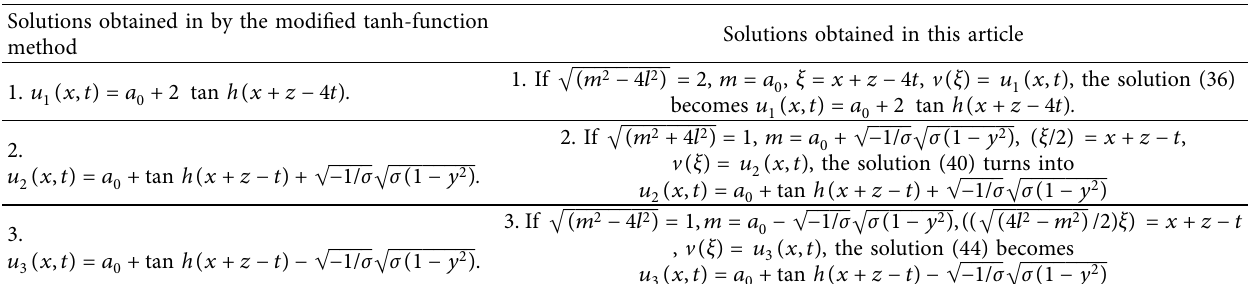
Solutions obtained in this article